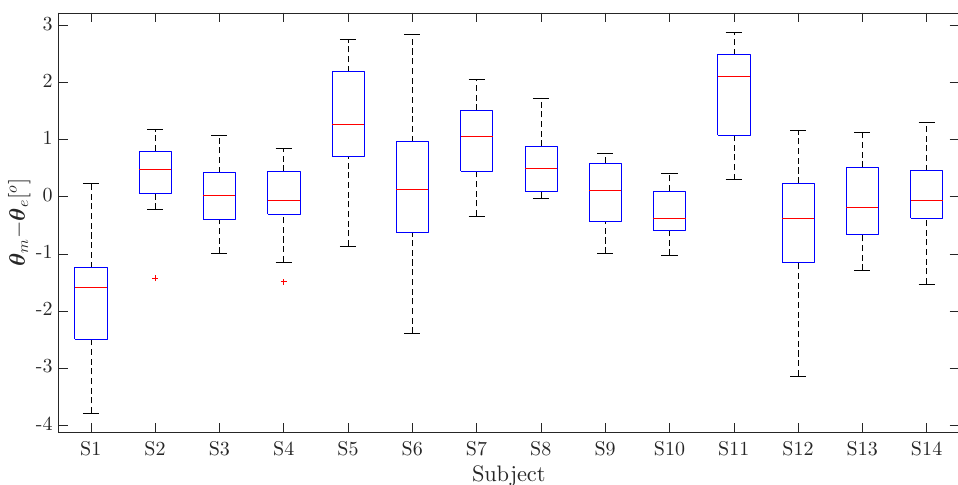
Figure 9. RMSE between the estimated and reference femur orientation. The accuracy is defined by a root mean square error (RMSE). The red line in Figure 9 represents the median of the data, whereas the blue rectangles represent the interquartile range (between the first and third quartiles). The dashed line represents the data outside of this range, with several outliers denoted as red plus sign. The error median fits